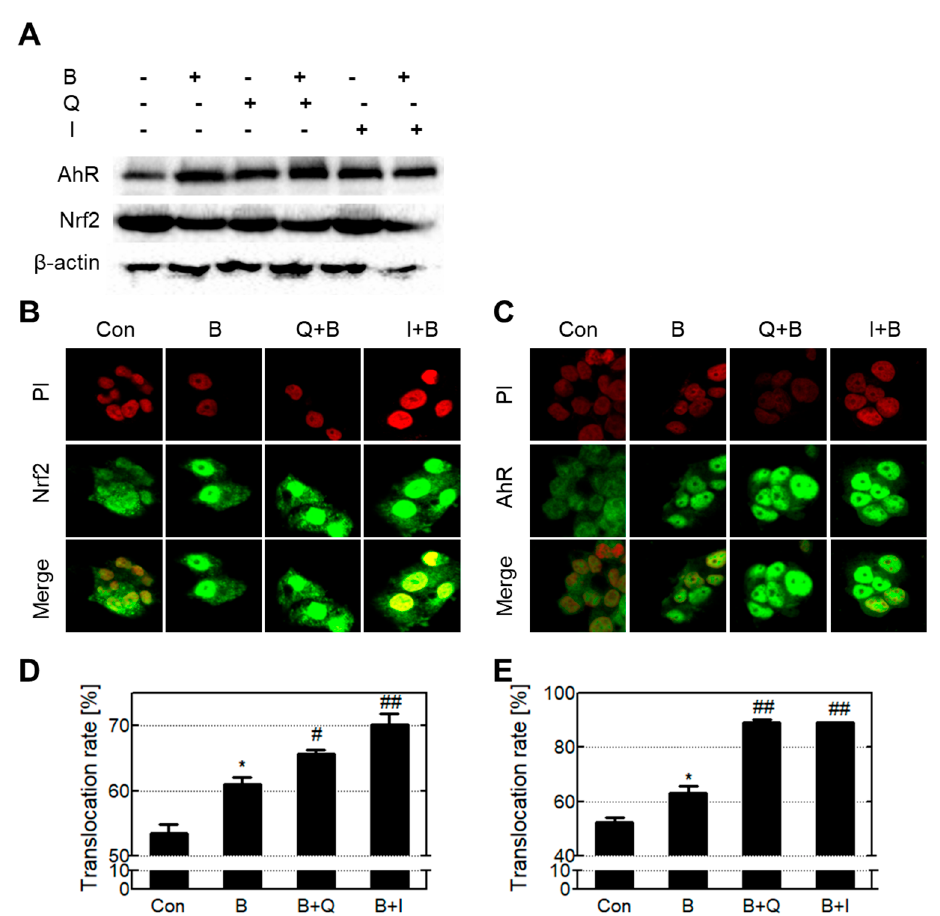
Figure 6. Increased translocation of NRF2 and AhR induced by quercetin and isorhamnetin. ( A ) Examination of intracellular protein levels of NRF2 and AhR. ( B , C ) Analysis of ( B ) NRF2 and ( C ) AhR translocation by confocal microscopy. ( D , E ) Quantification and graphical presentation of the translocation rates of ( D ) NRF2 and ( E ) AhR. * p < 0.05 compared with the control; # p < 0.05, ## p < 0.01, compared with B[a]P-treated cells. Con: control; B: benzo[a]pyrene (B[a]P) (10 µ M); Q: quercetin (5 µ M); I: isorhamnetin (5 µ M).